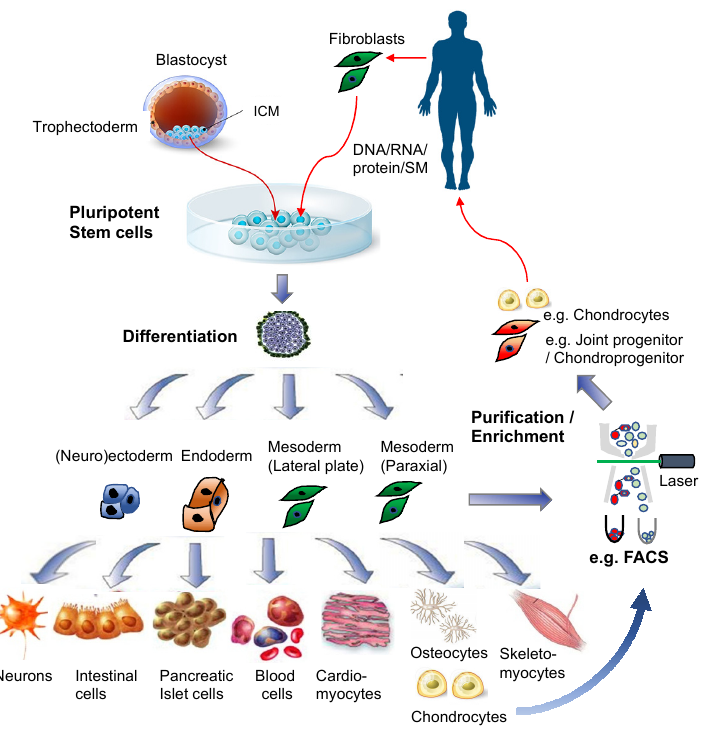
Figure 2. Pluripotent stem cells for regenerative medicine. Illustrations for the blastocyst, pluripotent stem cells, and differentiated cells were purchased from Dreamstime.com.